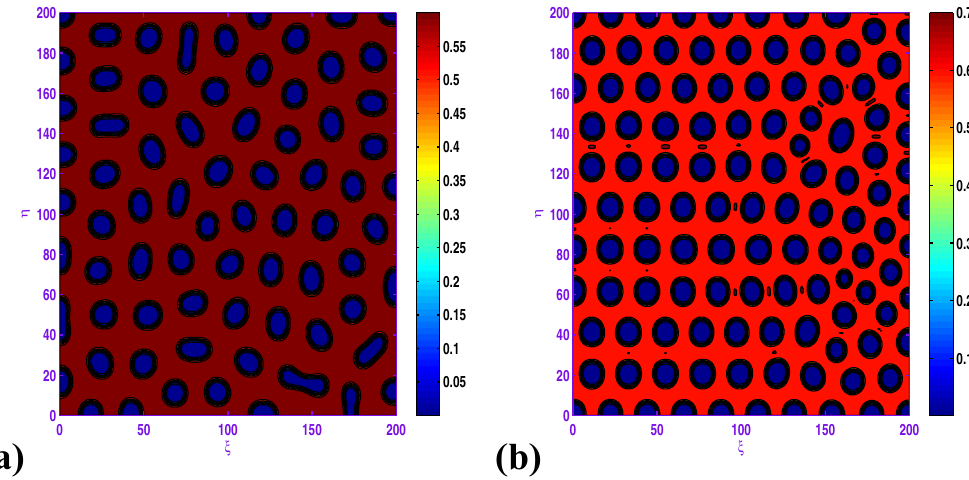
Figure 10. Transition of spatial dynamics of the prey population ( u ) in the model (9) at t = 5000 , for the set: a = 0.5 , b = 1.0 , β = 1.05 , d = 0.3 , d